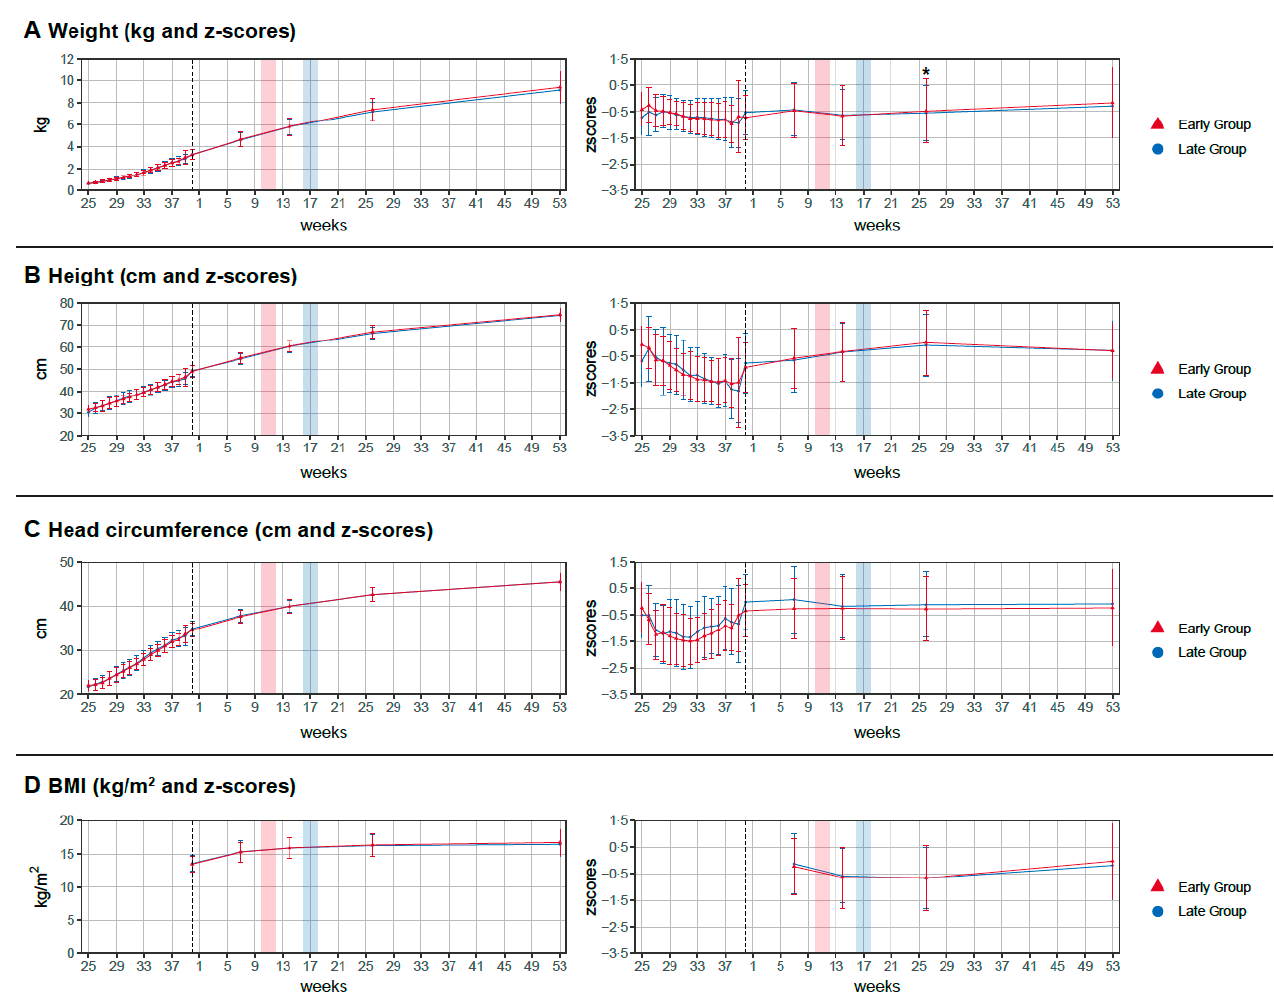
Figure 4. Anthropometric data of the study population. Plot A: This plot shows the weight gain in kilogram and corresponding z-scores of the study population during the first year of life including data from birth to date of expected term. The asterisks mark a significant p -value <0.05. Plot B: This plot shows the height growth in cm and corresponding z-scores of the study population during the first year of life, including data from birth to date of expected term. Plot C: This plot shows the gain in head circumference weight gain in cm and corresponding z-scores of the study population during the first year of life, including data from birth to date of expected term. Plot D: This plot shows the changes in BMI (body mass index) and corresponding z-scores of the study population during the first year of life, including data from birth to date of expected term. Reference values are only available for infants after term; therefore, data before expected date of term are missing. The red bar represents the time point of introduction of complementary food in the early group (10–12 weeks, corrected for term) and the blue bar represents corresponding time point for the late group (16–18 weeks, corrected for term). 4. Discussion This is the first prospective interventional study in preterm infants investigating the introduction of a standardized complementary diet at two different timepoints and its effect on growth during the first year of life. Early or late introduction of complementary food did not affect height, which is a reliable predictor for skeletal growth and fat-free body mass, but had a transient short-term effect on weight z-scores at six months, indicat- ing a more rapid weight gain in the early complementary food group. Furthermore, this